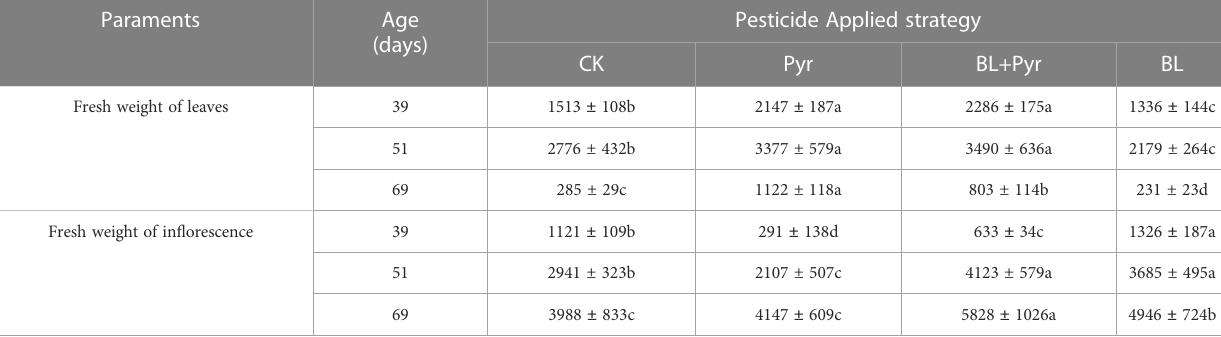
TABLE 2 The fresh weight (mg) of rosette leaves and in fl orescence during the reproductive development stage.